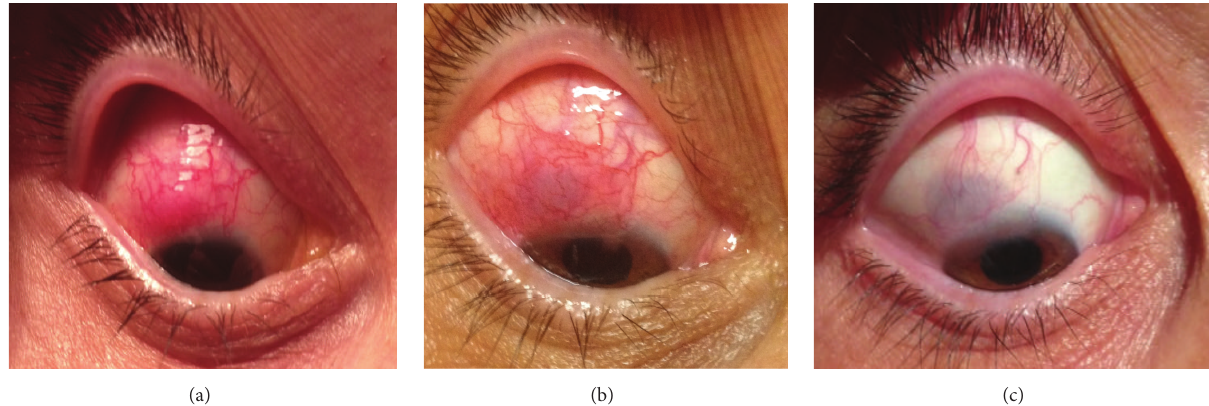
Figure 1: Clinical evolution of anterior nodular scleritis associated with varicella zoster virus. (a) Initial reddish scleral nodule with dilated vessels. (b) Clinical improvement with oral prednisolone 40 mg daily, less hyperemia, and flattening of the nodule. (c) Clinical resolution after methotrexate therapy; the underlying uveal tissue is visible through the thinned sclera giving it a blue-gray appearance.